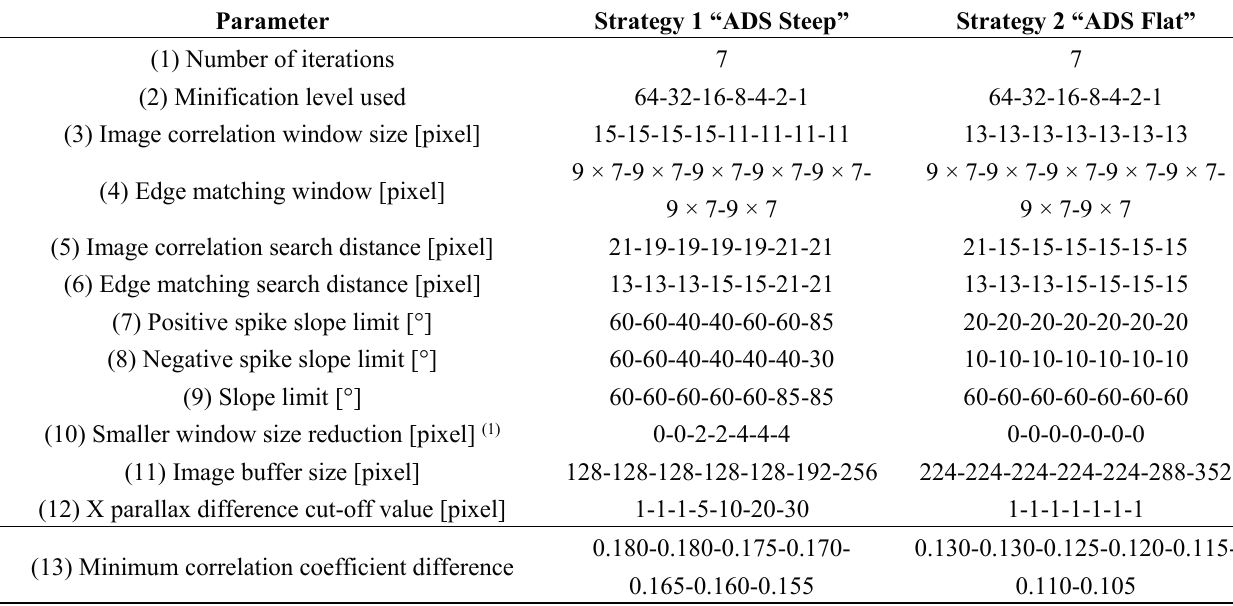
Table 1. Parameter sets of the two image matching strategies used in the image correlation workflow. The algorithm iterates seven times using the pyramid levels of the images. The seven values listed in the table correspond to the number of